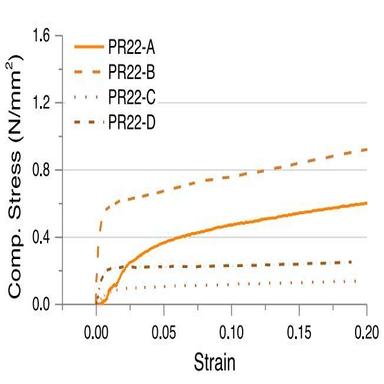
Stress–strain plots (PR32).